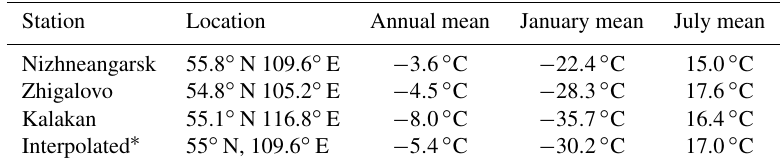
Table 4. Station temperature data near Lake Baikal averaged over